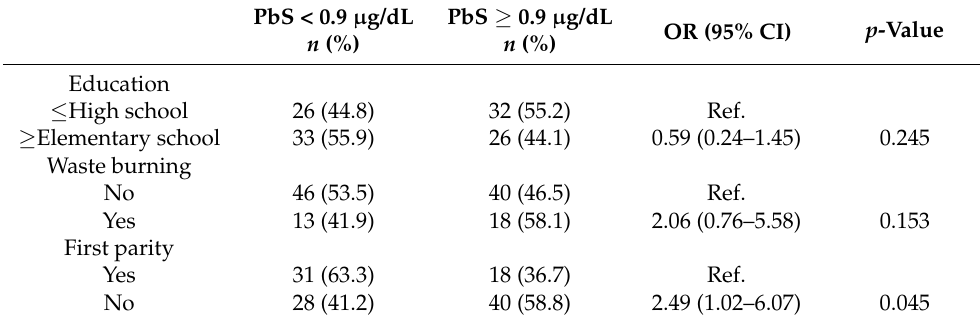
Table 4. Determinants of PbB levels above the median after χ 2 and MLR test.